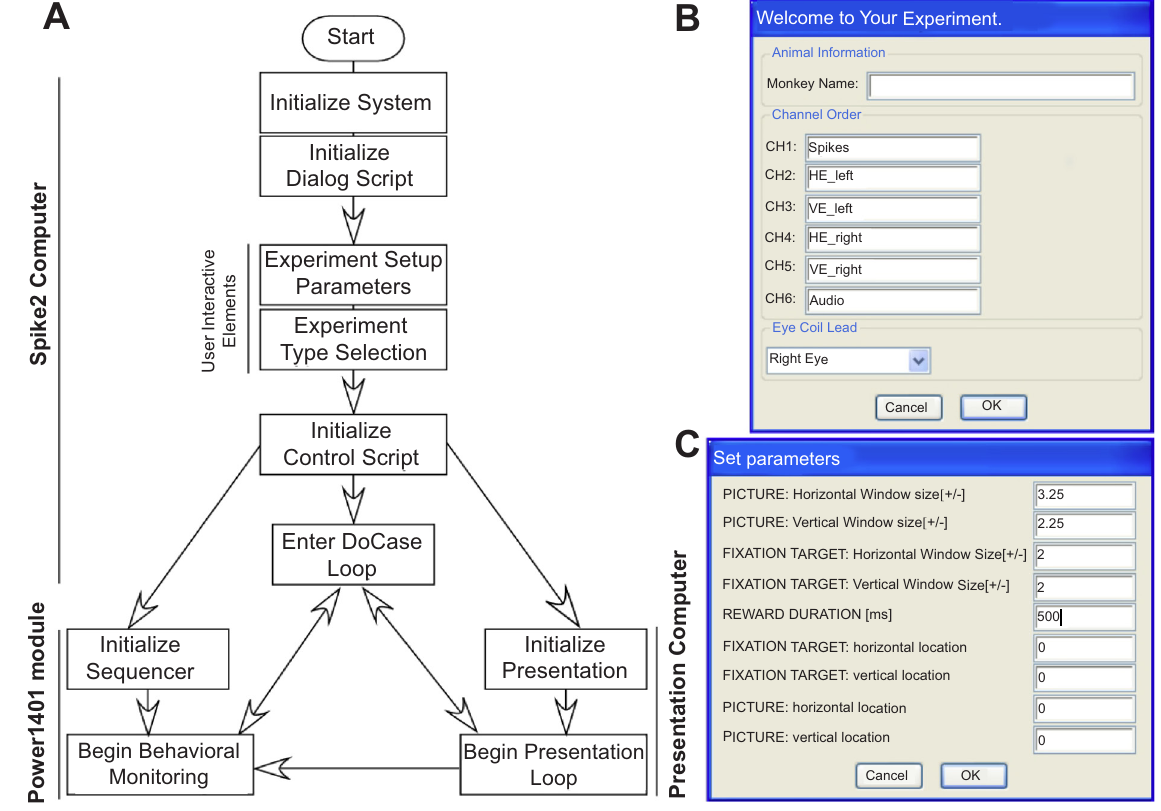
Figure 2. Details of script and user input . A . Flow chart showing the design of experiment control sequence shared between the four scripts. B . The initial interactive user-interface used to collect basic information about the experiment set-up. C . User-interface used to collect the initial parameters for behavioral monitoring of subjects during